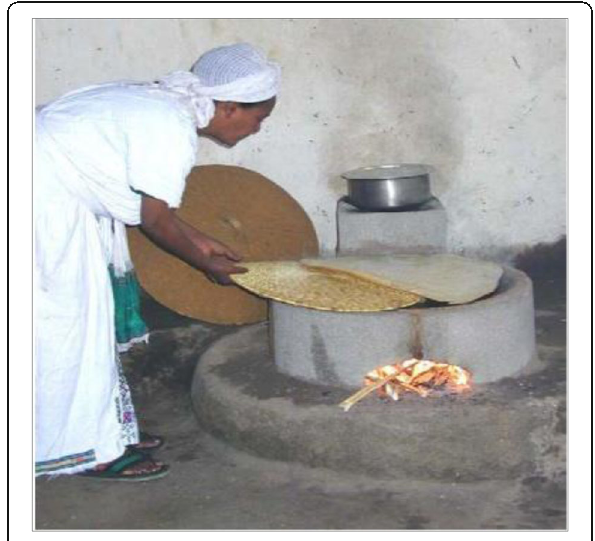
Fig. 1 Mirt improved cookstove technology. Source: The World Bank